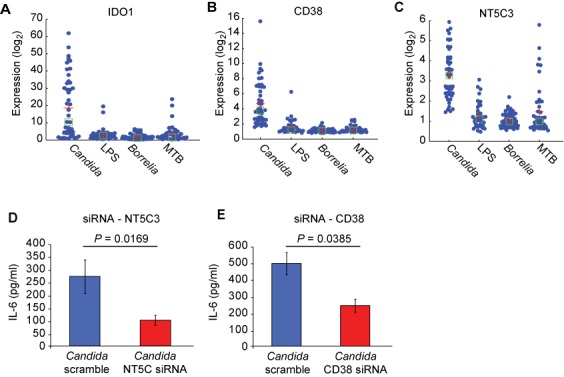
Identification of gene–environment interactions in host immunity. (A,B,C) Gene expression of select driver genes identified in tryptophan metabolic pathway (IDO1) and nicotinamide metabolism (CD38, NT5C3). (D,E) Effect of knocking down CD38 and NT5C3 on IL-6 production in response to ex vivo stimulation of PBMCs from healthy individuals with Candida conidia.